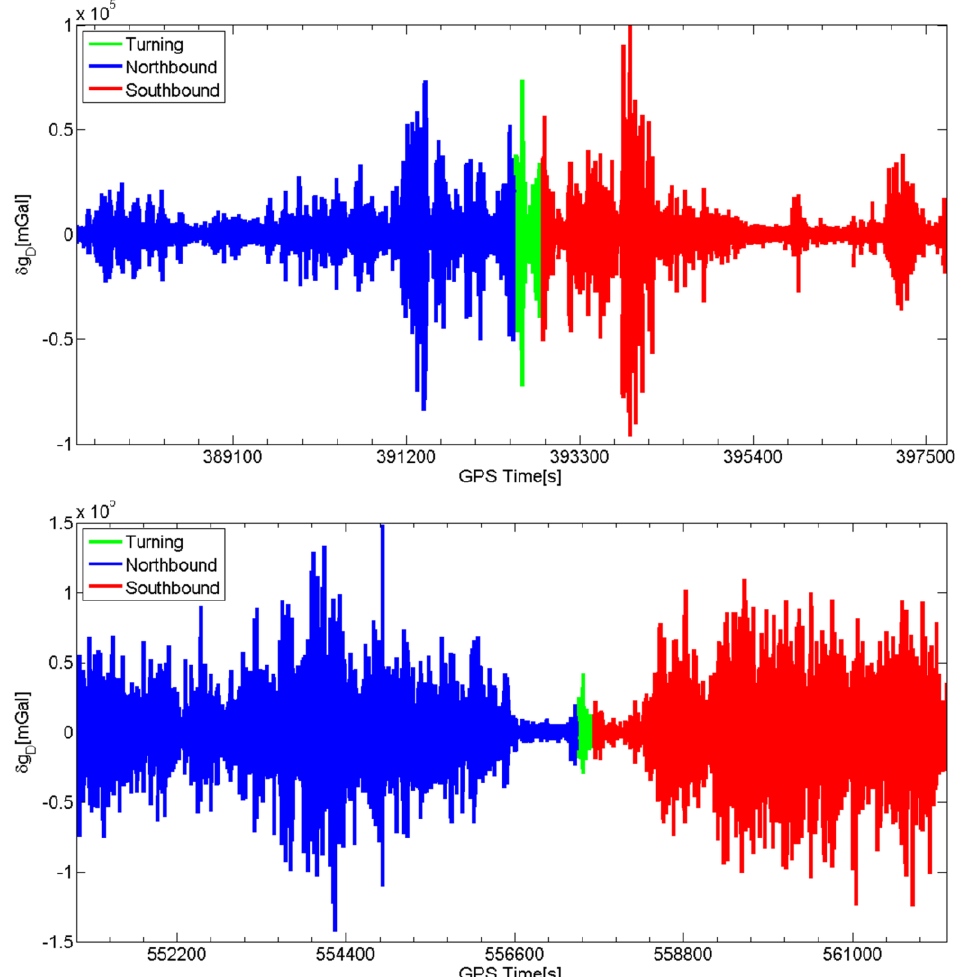
Figure 5. Raw gravity measurements of repeated profile A ( top ) and B ( bottom ). The segments shown in blue and red denote the northbound and southbound separately and the green line represents the 180 degree turning time during the flights. The difference varies by over 10 5